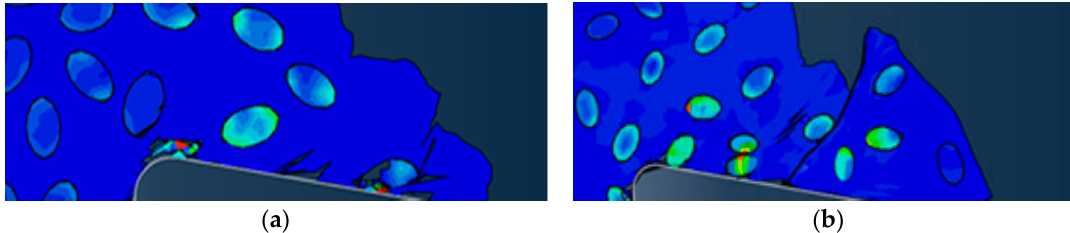
Figure 28. Factors affecting chip morphology: ( a ) Chip geometry changes with particle ratios 50%, ( b ) chip geometry changes with particle ratios 20%.